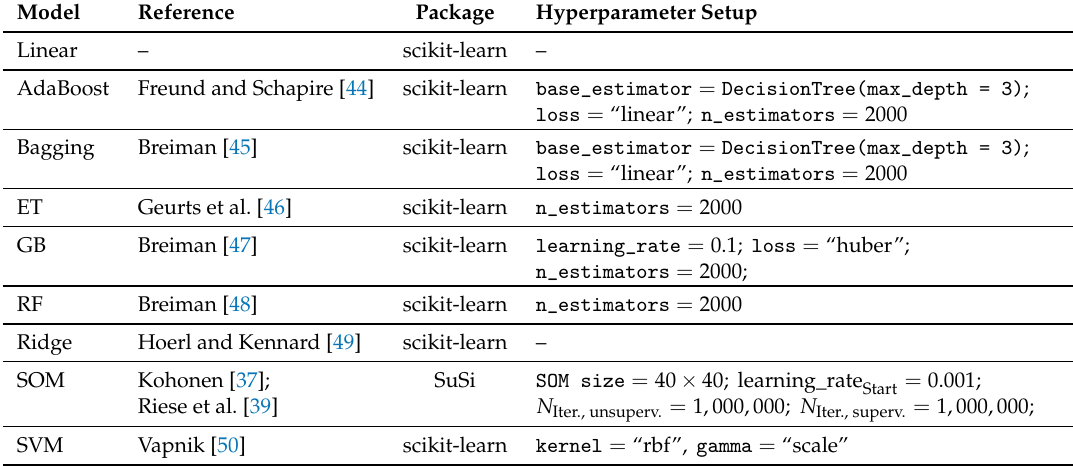
Table A2. Hyperparameter setup for the estimation framework with scaling. This setup is obtained by a basic grid search and some manual tuning. Only nondefault parameters are listed. The regressors are implemented mostly in scikit-learn [35]. The SOM is implemented according to Riese